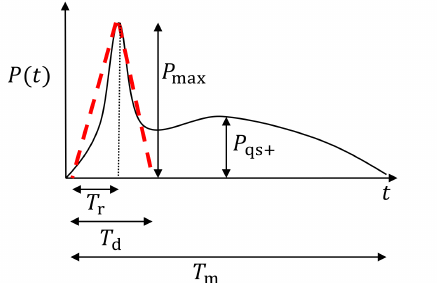
Figure 9. Time-histories of typical breaking or impulsive wave load (in black) with idealized church-roof wave impulse (in red) according to Oumeraci and Kortenhaus [25]. The idealized time-histories is also adopted in this